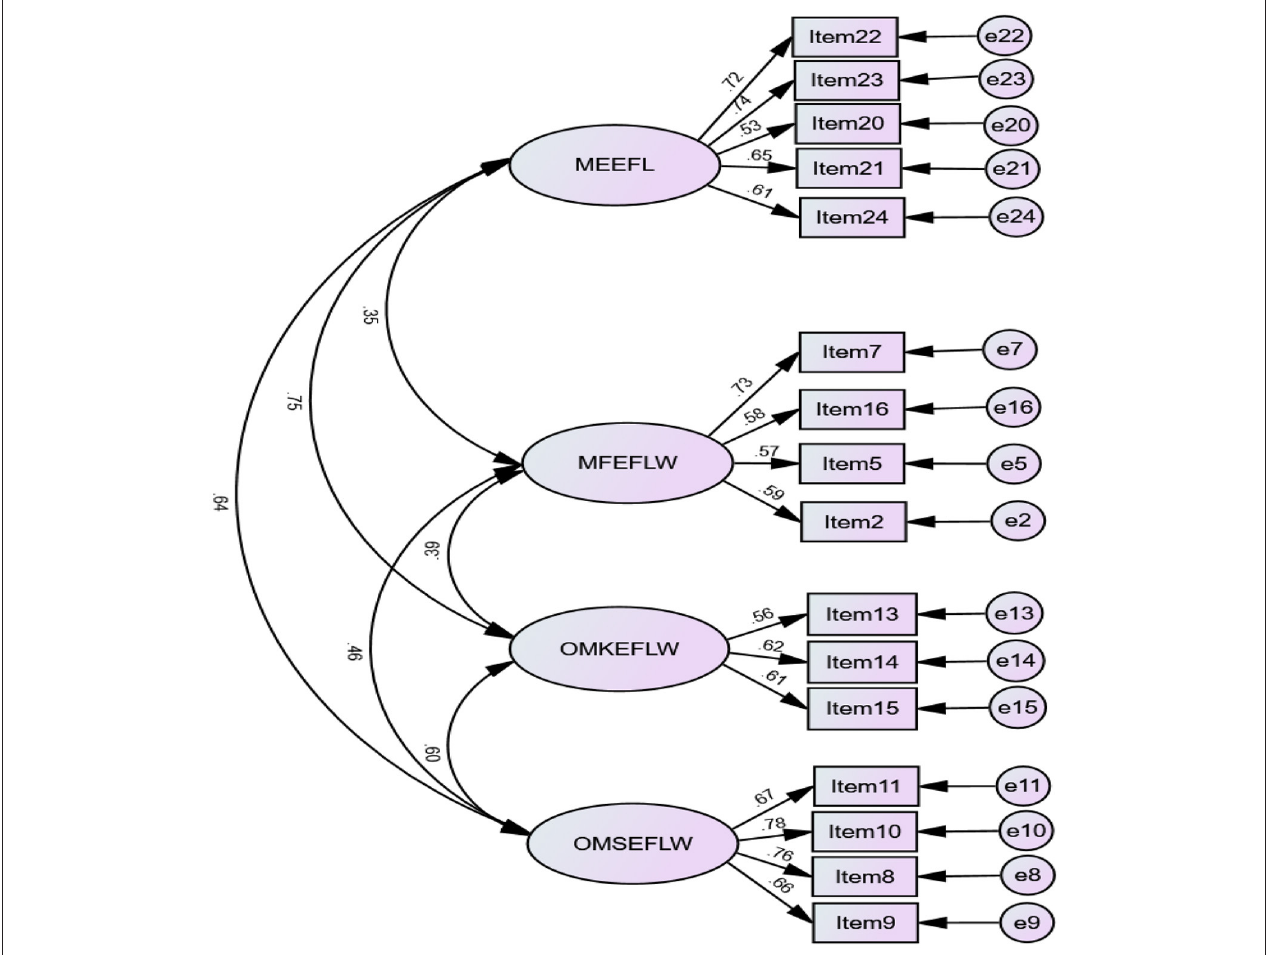
FIGURE 1 | A Four-Factor Model of EFL Writing Metacognitive Experiences ( N = 513). MEEFLW, Metacognitive Estimates of EFL Writing; MFEFLW, Metacognitive Feelings of EFL Writing; OMKEFLW, Online Metacognitive Knowledge of EFL Writing; OMSEFLW, Online Metacognitive Strategies of EFL Writing.